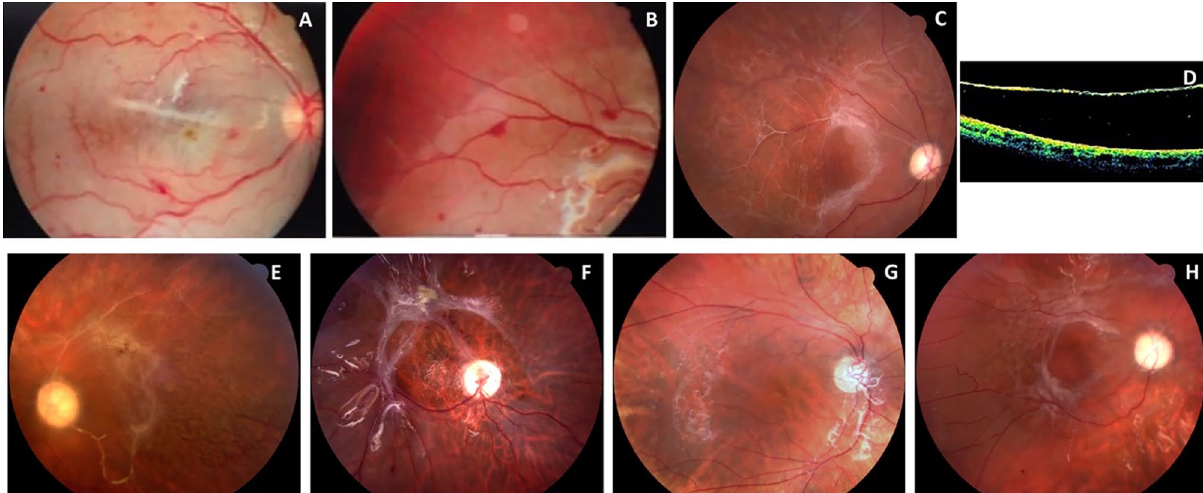
Figure 2. Clinical pictures from six Chilean patients. Retinographies from the Punta Arenas’ case showed evidence of retinal necrosis and small intraretinal haemorrhages at the posterior pole ( A ) and the edge was at the border of the PFO filling ( B ). The other images are from San Borja cases. They all display optic nerve atrophy. Case 1 shows PVR with epiretinal membranes ( C ) and thin retina detached on OCT ( D ). Case 2 looks similar to Case 1, with even more ghost vessels ( E ). Case 3 shows proliferative vitreoretinopathy with thick epiretinal membranes and a huge hole at the posterior pole ( F ). Case 4 displays signs of retinal atrophy ( G ). Case 5 shows epiretinal membranes and a huge macular hole ( H ).